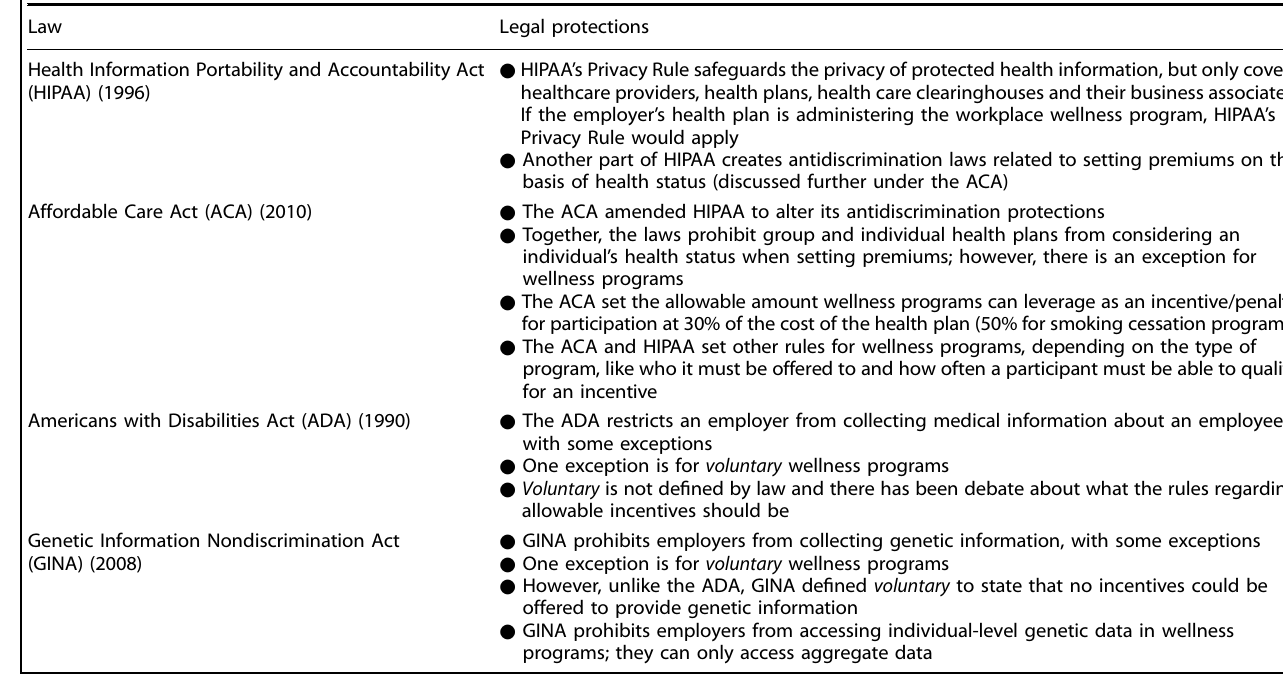
Table 1. US laws regulating workplace wellness